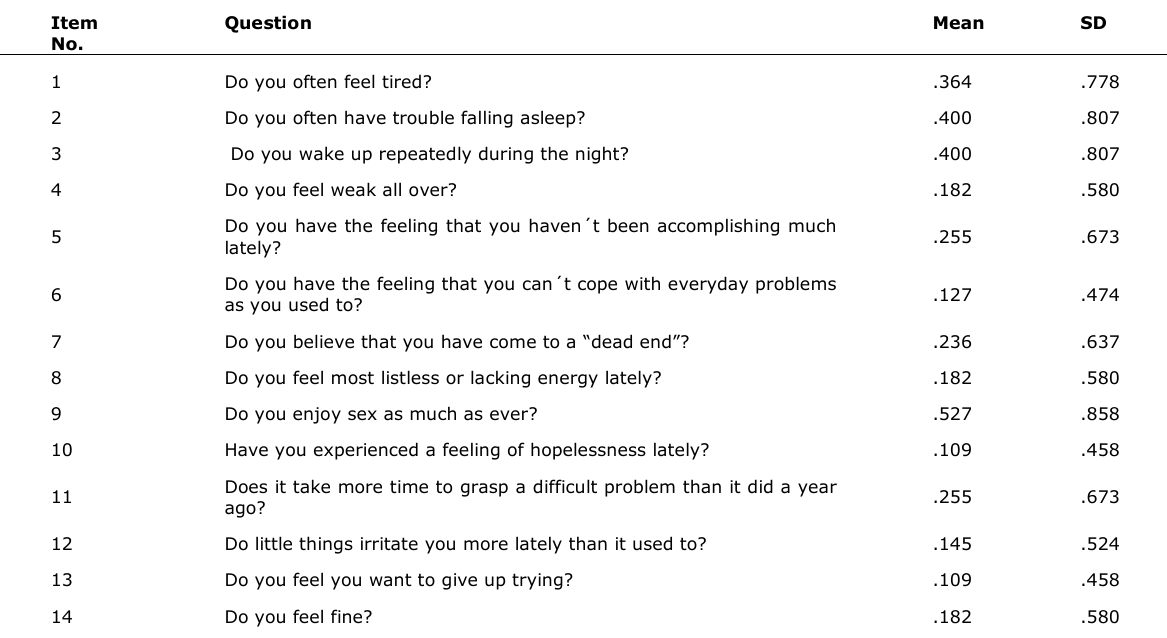
Table 2. Mean rating scores of MVEQ questions of off-shore